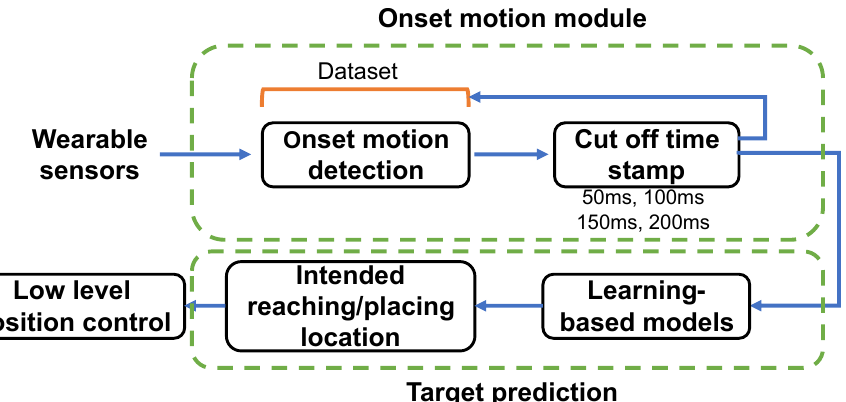
Figure 1. Overview of the proposed learning-based controller. The onset motion data are acquired from different sensory interfaces. The input features are then computed for four onset time windows of motion. Then, the processed motion samples are given as input to multiple learning-based intention prediction models for end-point prediction. Finally, the target end-point positions will be given as a reference point to the low-level controller for the robot to